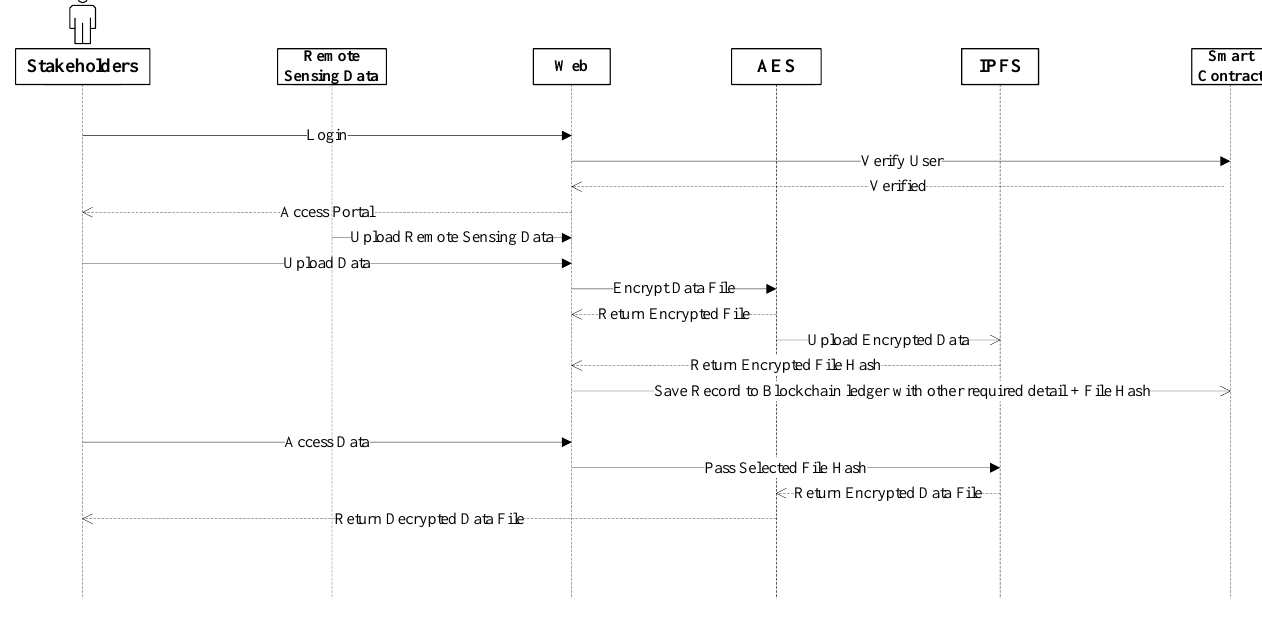
Figure 7. System sequence process for remote sensing datasets.